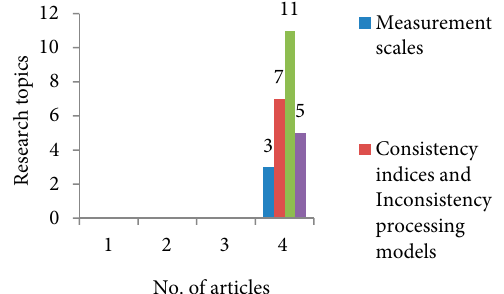
Fig. 3. The distribution of researches on the main developments of interval (fuzzy)